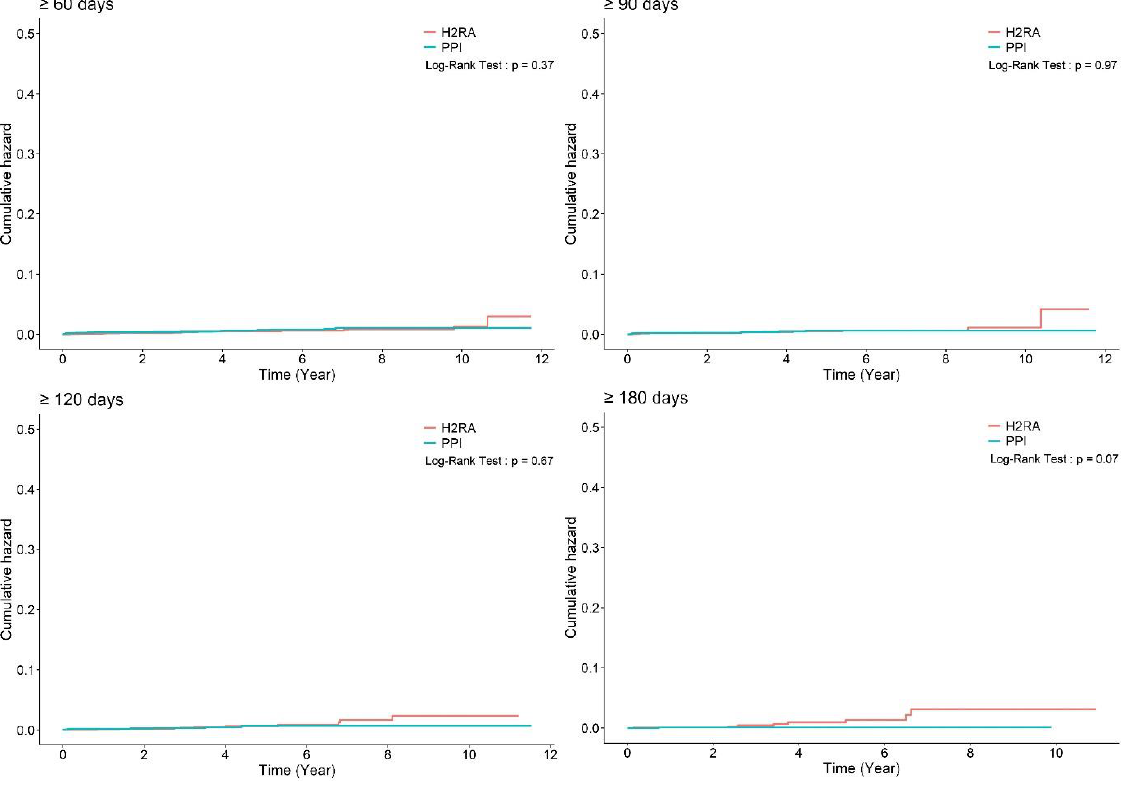
Figure 2. Cumulative hazard plot of gastric cancer development according to the duration of medication. H 2 RA, histamine-2 receptor antagonist; PPI, proton pump inhibitor.